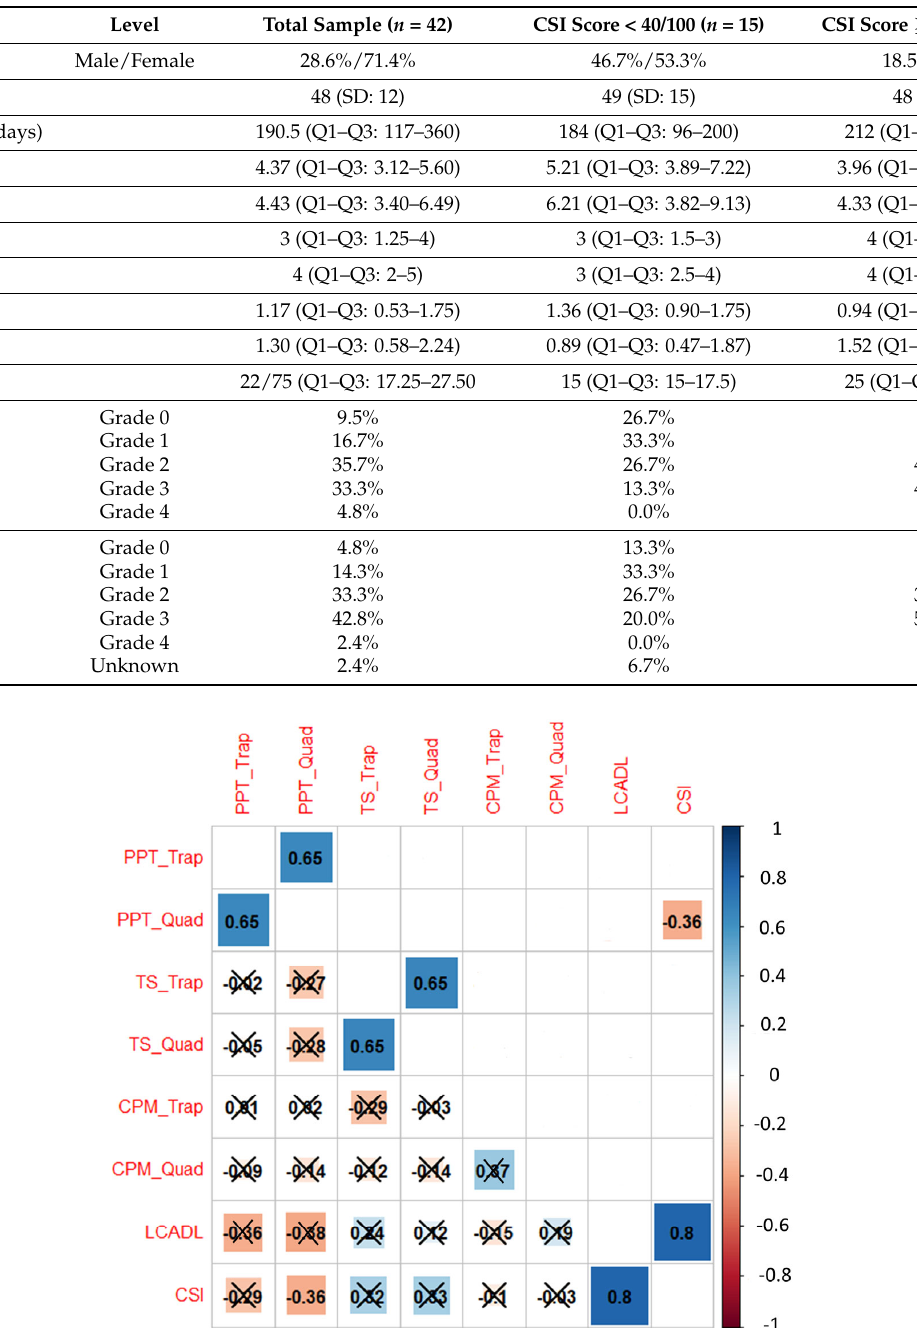
Figure 1. Correlation plot. The correlation coefficients range from − 1 (red) to +1 (blue) and are presented with their actual values on the plot. In the lower triangle, correlations that are not statistically significant are marked with a cross. On the upper triangle, only statistically significant correlations are presented. Abbreviations: CPM: conditioned pain modulation, CSI: central